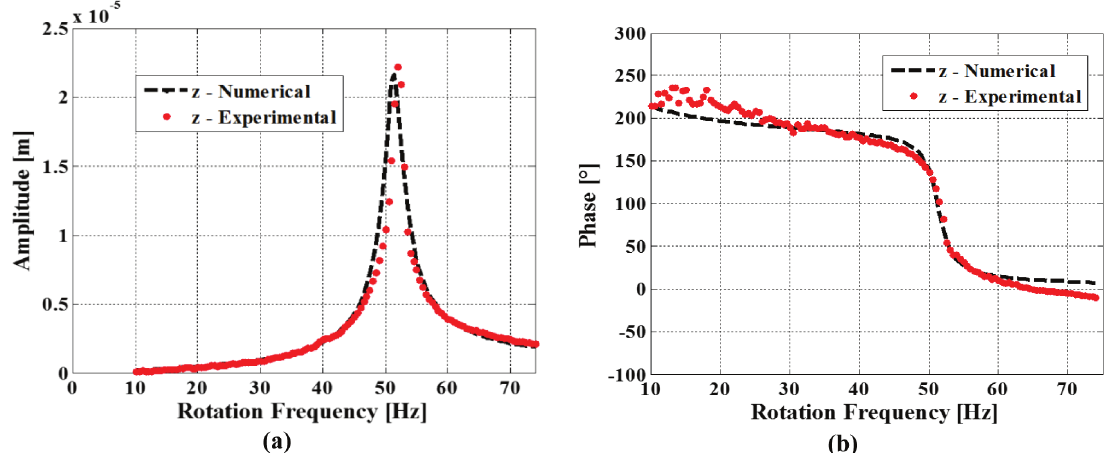
Figure 12 - Unbalanced frequency responses at Bearing 2, vertical direction: (a) amplitude and (b)